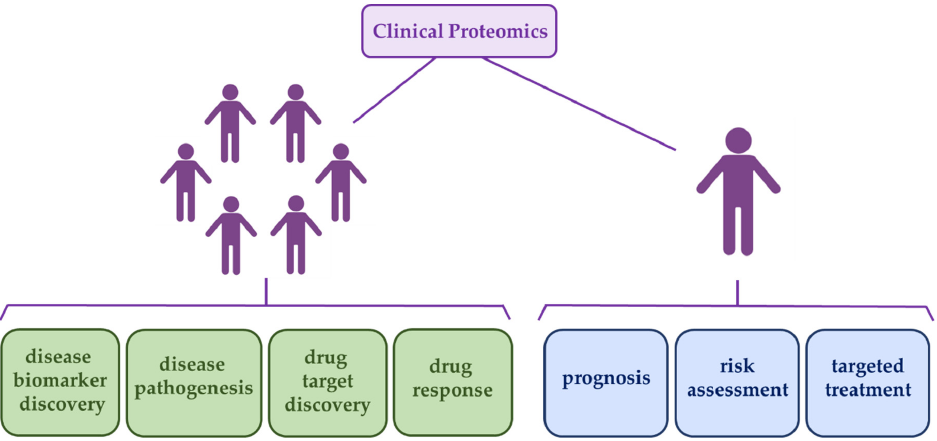
Figure 1. Most potential applications of clinical proteomics in human disease. Population-based applications are shown in green boxes and individual-based applications (also known as personalized medicine) are shown in blue boxes. The human figure was obtained from BioRender (https://biorender.com/).